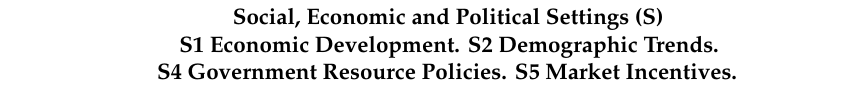
Table 1. Analytical Framework (adapted from Ostrom